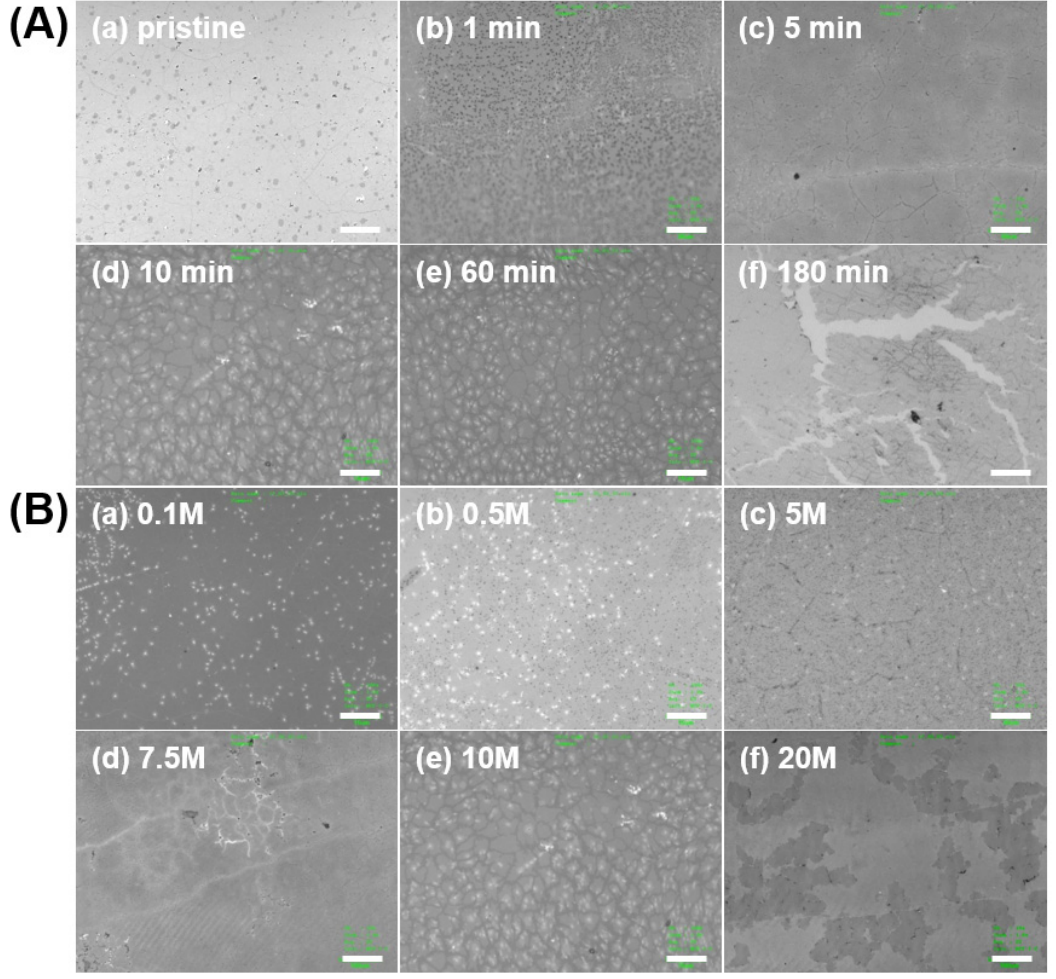
Figure 3. Morphology of irregularly patterned GP meshes obtained by optical microscope. ( A ) effect of etchant treatment time (0–180 min) on the morphology of GP mesh using HNO 3 (10 M) as